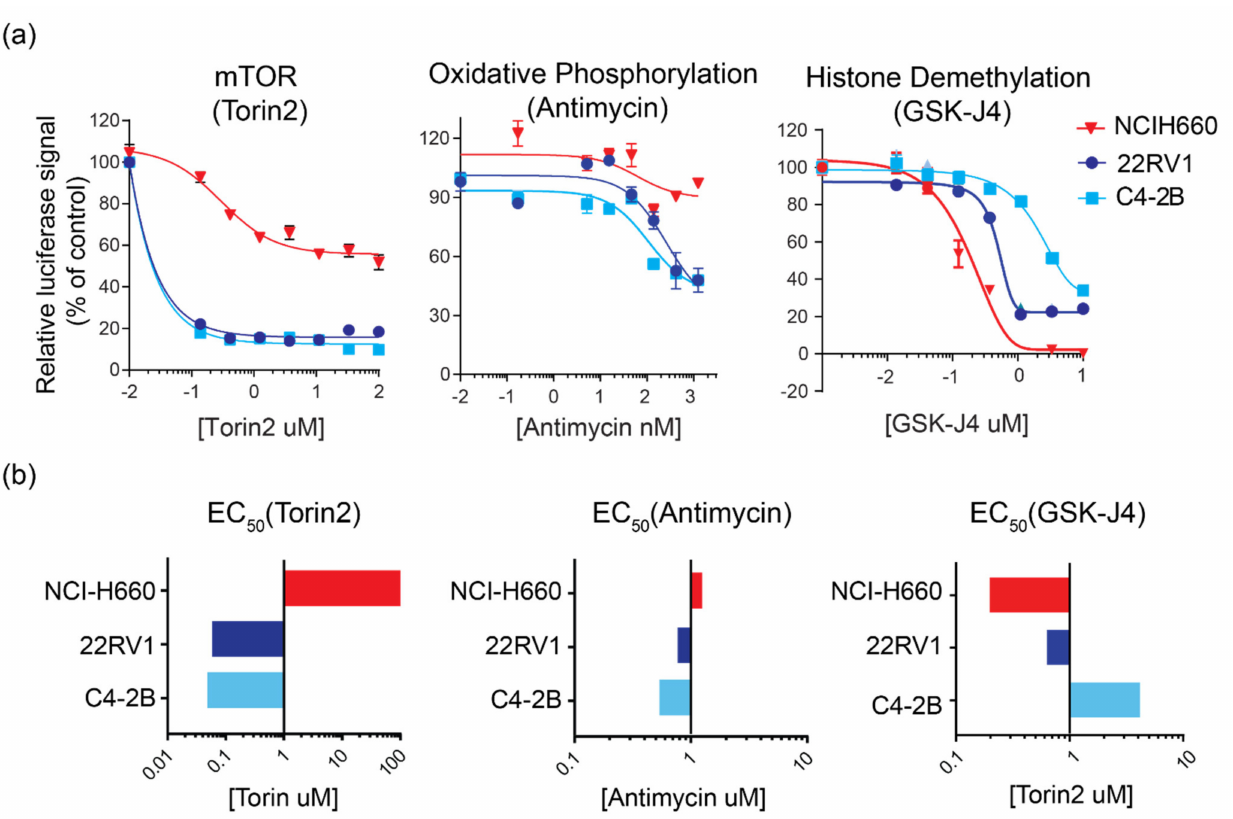
Figure 4. Perturbation studies confirm subtype-specific therapeutic vulnerabilities in prostate cancer cell lines. ( a ) Dose-response curves showing the effect of Torin2 (mTOR inhibitor), antimycin (ox- idative phosphorylation inhibitor), and GSK-J4 (histone demethylase inhibitor) on the viability of AR-null and AR-positive cell lines. n = at least three biological replicates. ( b ) Bar graphs summarizing the effective drug concentration 50% (EC 50 ) of Torin2, antimycin, and GSK-J4 measured in the PC cell